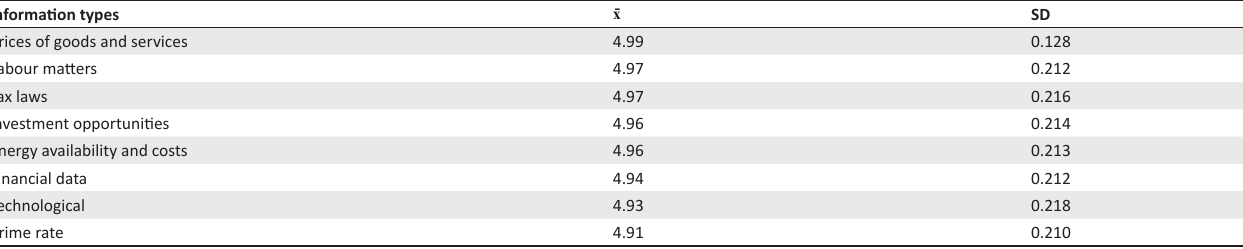
TABLE 3: Mean and standard deviation score of types of information utilised by the respondents.